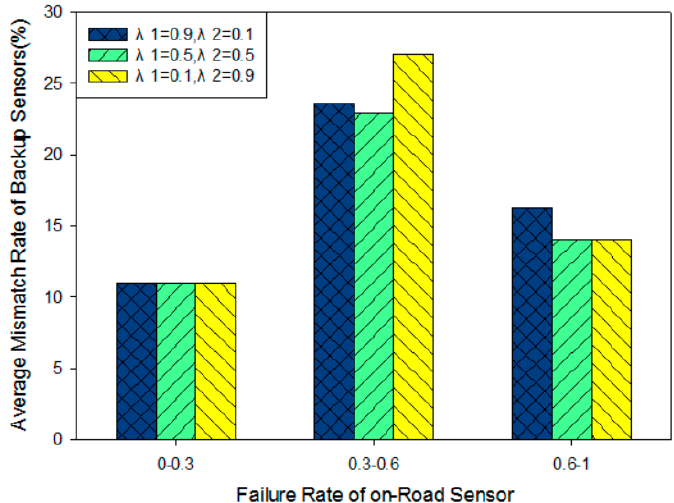
Figure 15. Relation between average mismatch rate and failure rate for each sensor with different values of λ 1 , λ 2